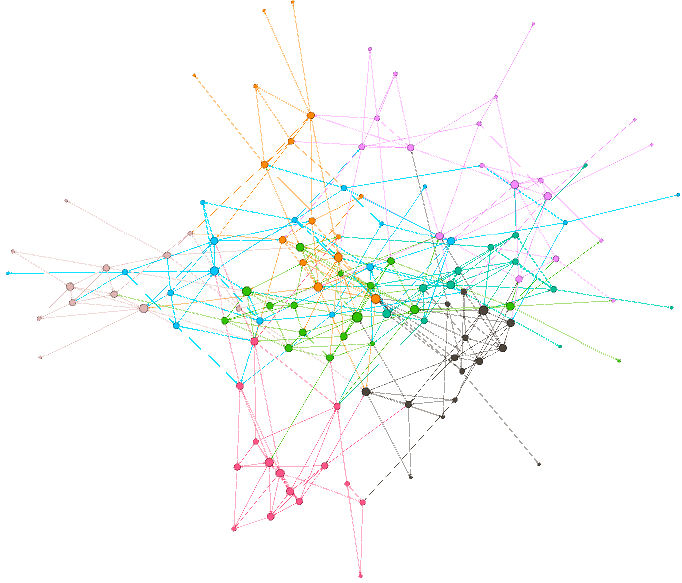
Figure 1. Friendship network of the sampled middle school students. The colors of the edges (lines) indicated the modularity of the nodes, i.e., the community. The size of the nodes indicated the in-degree of the nodes, i.e., how often a node (a student) was being nominated as friends of another node (student).